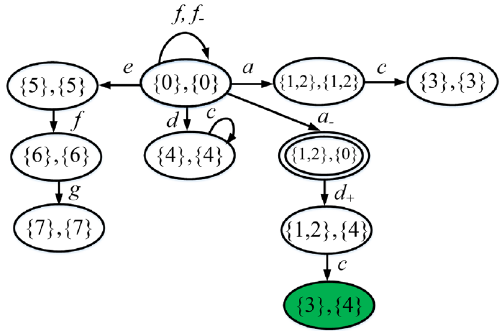
A in Example (cid:31)